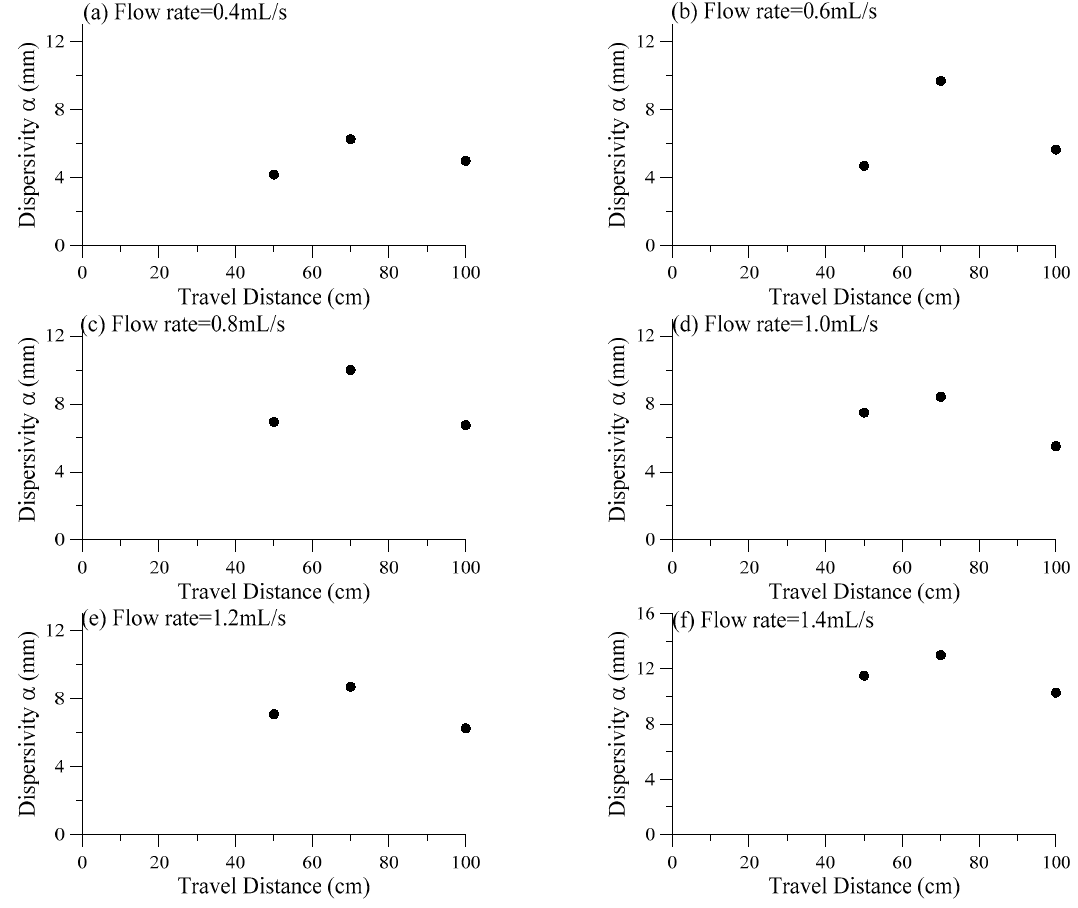
Figure 3. The best-fit dispersivity in the ADE model (29) versus the travel distance.